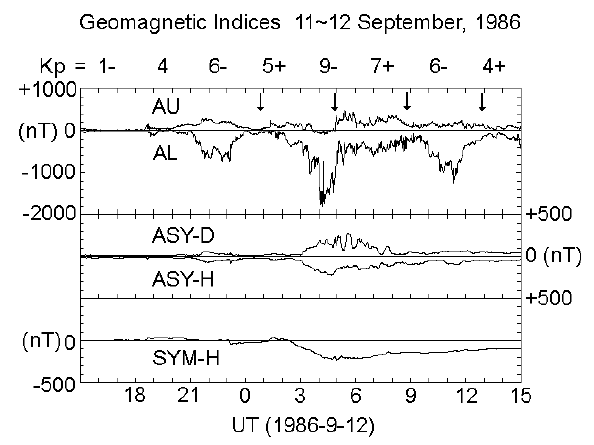
Fig. 2. Geomagnetic indices (AU, AL, SYM, and ASY) during and before the traversals displayed in Fig.